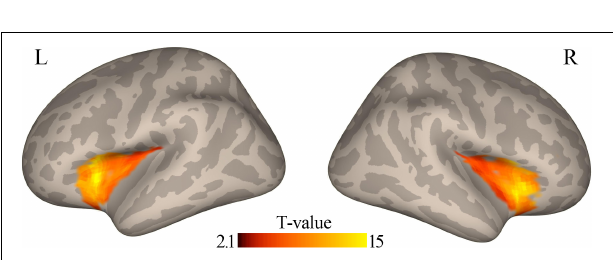
FIGURE 1 | Two weeks of rTMS induced significant decreases in HAMD scores ( t = 5.97, p < 0.001).